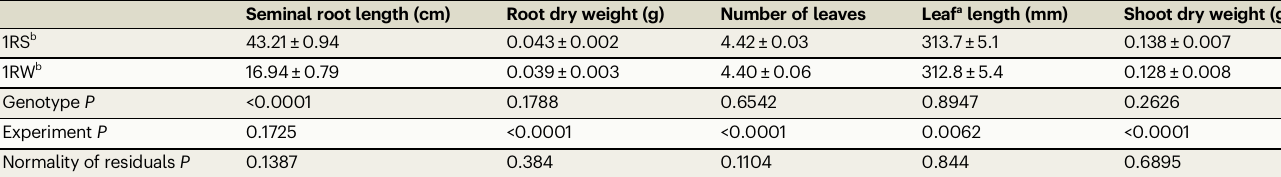
Table 1 | Comparison of root and aerial parts of 1RS and 1RW at 26